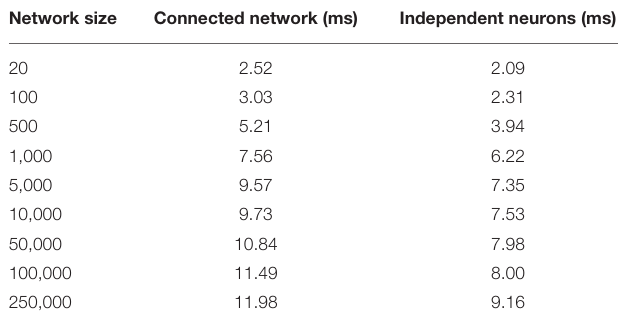
TABLE 6 | Simulation runtime in Loihi for independent neurons vs. connected network. Network